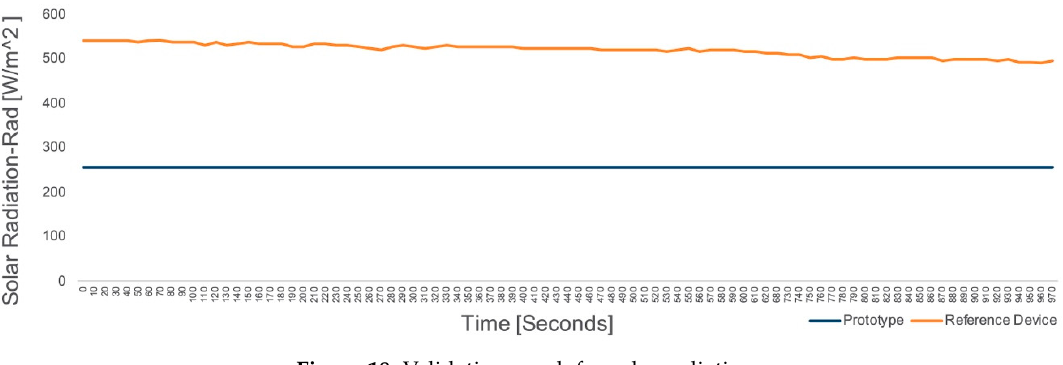
Figure 18. Validation graph for solar radiation.